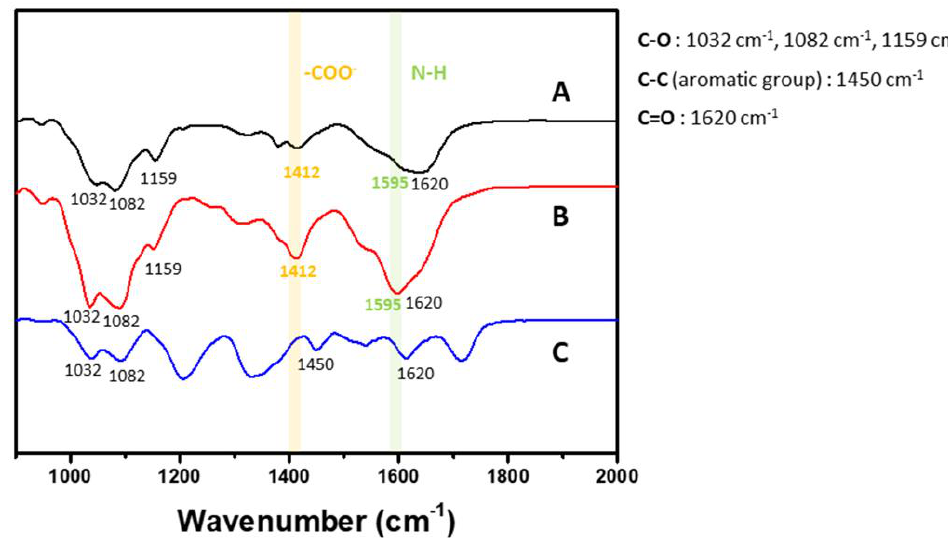
Figure 5. FTIR spectra of ( A ) (CHI/HA) 5 , ( B ) (CHI/ALG) 12 , and ( C ) (CHI/TA) 10 films.